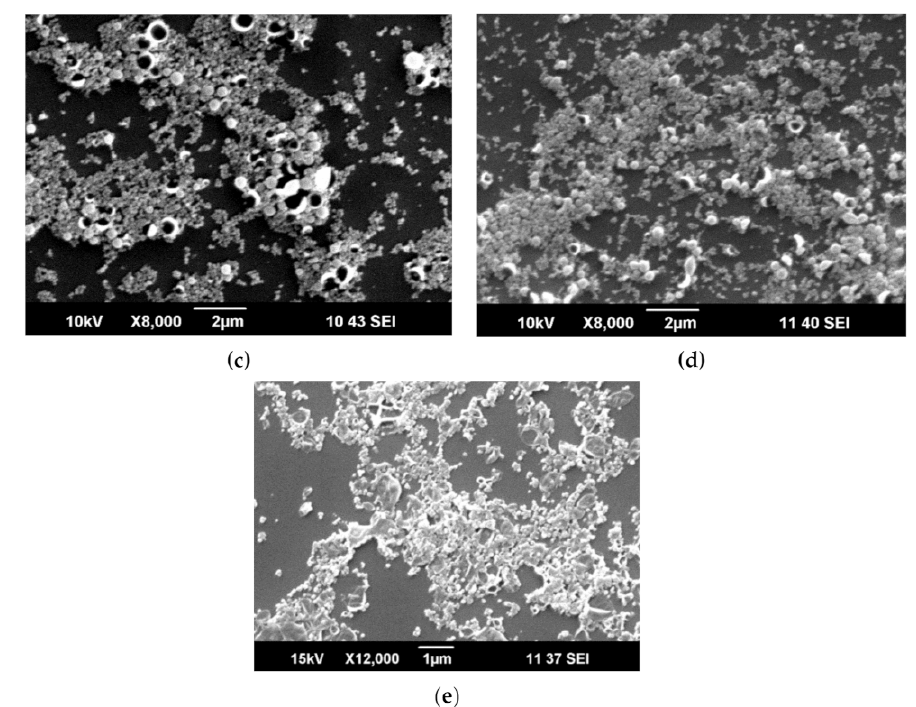
Figure 4. SEM images of pyraclostrobin-loaded submicrocapsules depending on OD:TPM ratio in the oil phase. ( a )—1:9; ( b )—1:4; ( c )—3:7; ( d )—2:3; ( e )—3:2. The concentration of pyraclostrobin (Pyr) in oil